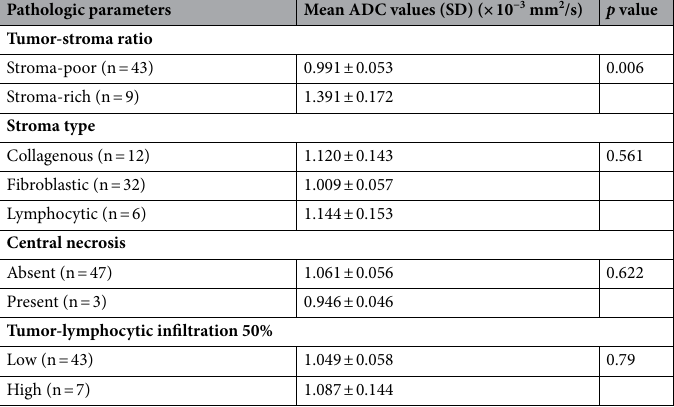
Table 2. Mean ADC † values according to pathologic parameters. † Apparent diffusion coefficient.